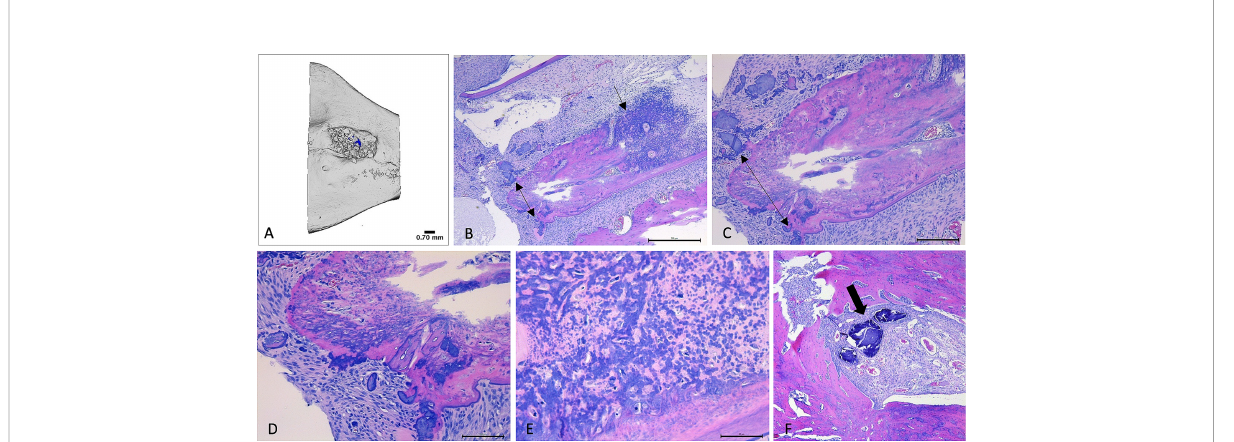
FIGURE 7 Micro-CT and histopathology images. (A – E) : Images (A) – Micro-CT, (B – E) Histology) collected from right hemimandible that tested positive for SA (Group III; rat 14). (A) : Micro-CT reconstructed image of defect area within mandible. Bone particles within irregularly shaped defect indicate presence of Bio-Oss ® Collagen. (B) : H&E-stained section of hemimandible, demonstrating mandibular bone (pink tissue) with severe, in fi ltrative in fl ammation (black arrow). Double-headed arrow highlights areas of necrotic bone. Findings are supportive of osteomyelitis. 5x magni fi cation. (C) : 10x magni fi cation of identical bone section. Double-headed arrow highlights areas of necrotic bone. (D) : 20x magni fi cation of identical bone section. Demonstrates areas of necrotic bone (dark purple), amid bone tissue (pink) that is in fi ltrated and distorted by in fl ammatory in fi ltrates. (E) : 40x magni fi cation of identical bone section, demonstrating in fi ltration and distortion of bone by in fl ammatory in fi ltrates amid areas of necrosis (light pink). (F) : H&E-stained histology section, 5x magni fi cation, of right hemimandible that was culture negative for SA (Group II, rat 10). Healthy mandibular bone (pink) surrounds a defect area containing Bio-Oss ® Collagen (thick arrow = bone particles) that has been in fi ltrated by blood vessels.